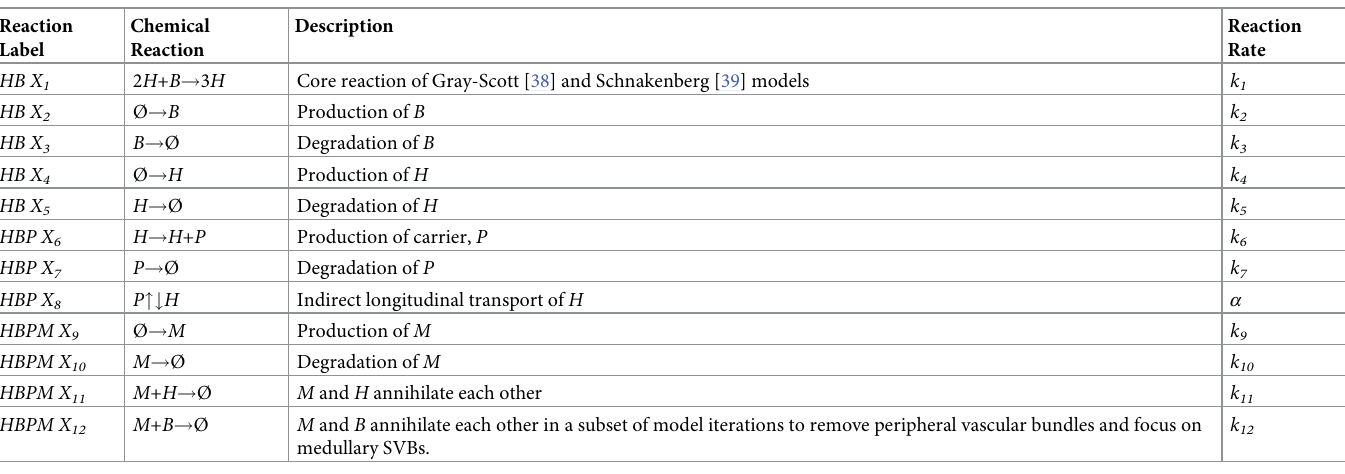
Table 1. Chemical